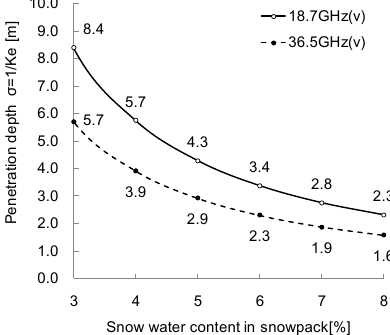
Figure 6. Variation in penetration depth associated with snow water content in snowpack in the range from 3 vol % to 8 vol %, while other parameters have optimum values (emissivity from ice sheet is 0.95, snow layer thickness is 0.95 mm in the upper layer and 0.05 m in the bottom layer, snow particle radius is 0.85 mm in the upper layer and 2.95 mm in the bottom layer, snow density is 0.10 g/cm 3 in the upper layer and 0.25 g/cm 3 in the bottom layer.